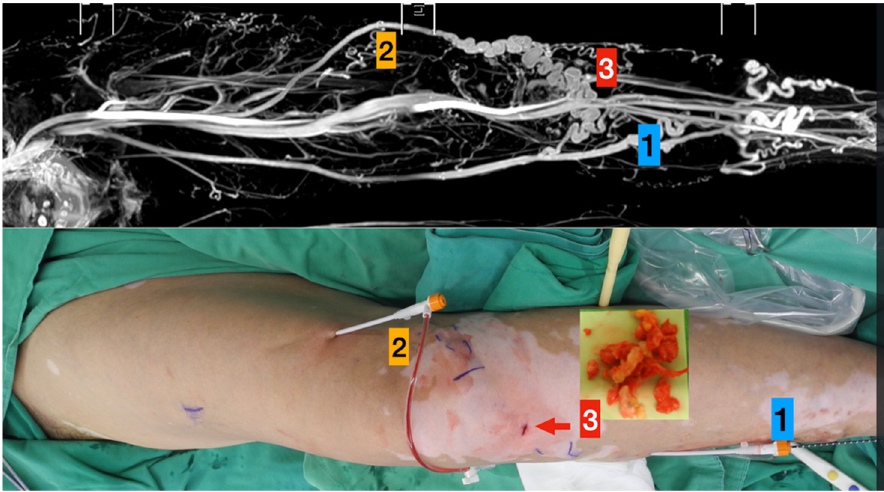
Figure 1. TRANCE MRI-Guiding superficial venous intervention.